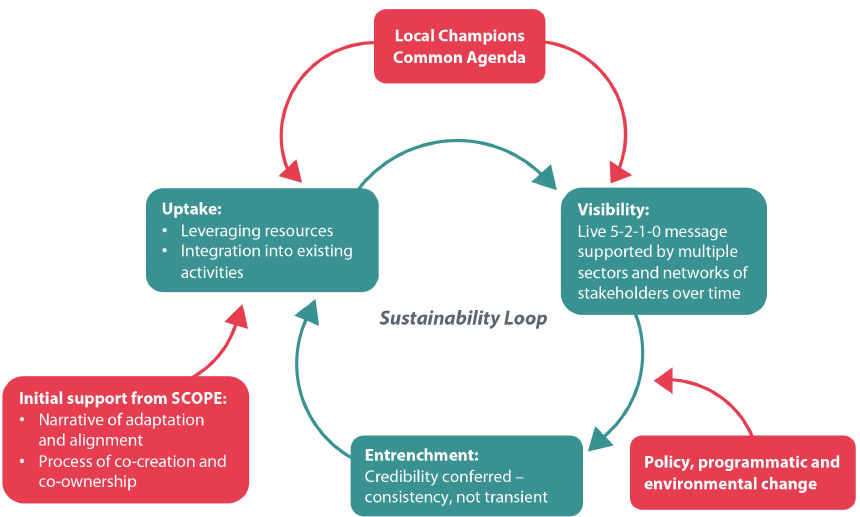
Figure 3. The reinforcing feedback loop that sustains Live 5-2-1-0 in a